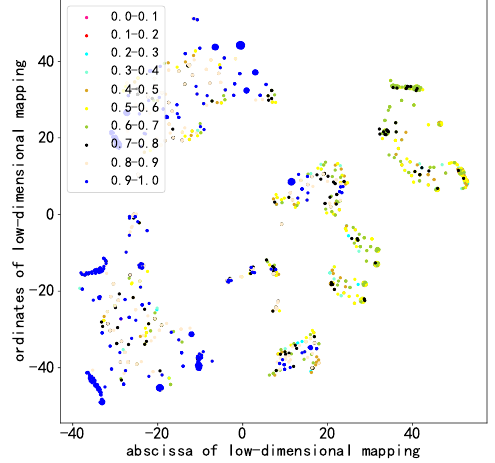
Figure 9. Dimension reduction of sequences of